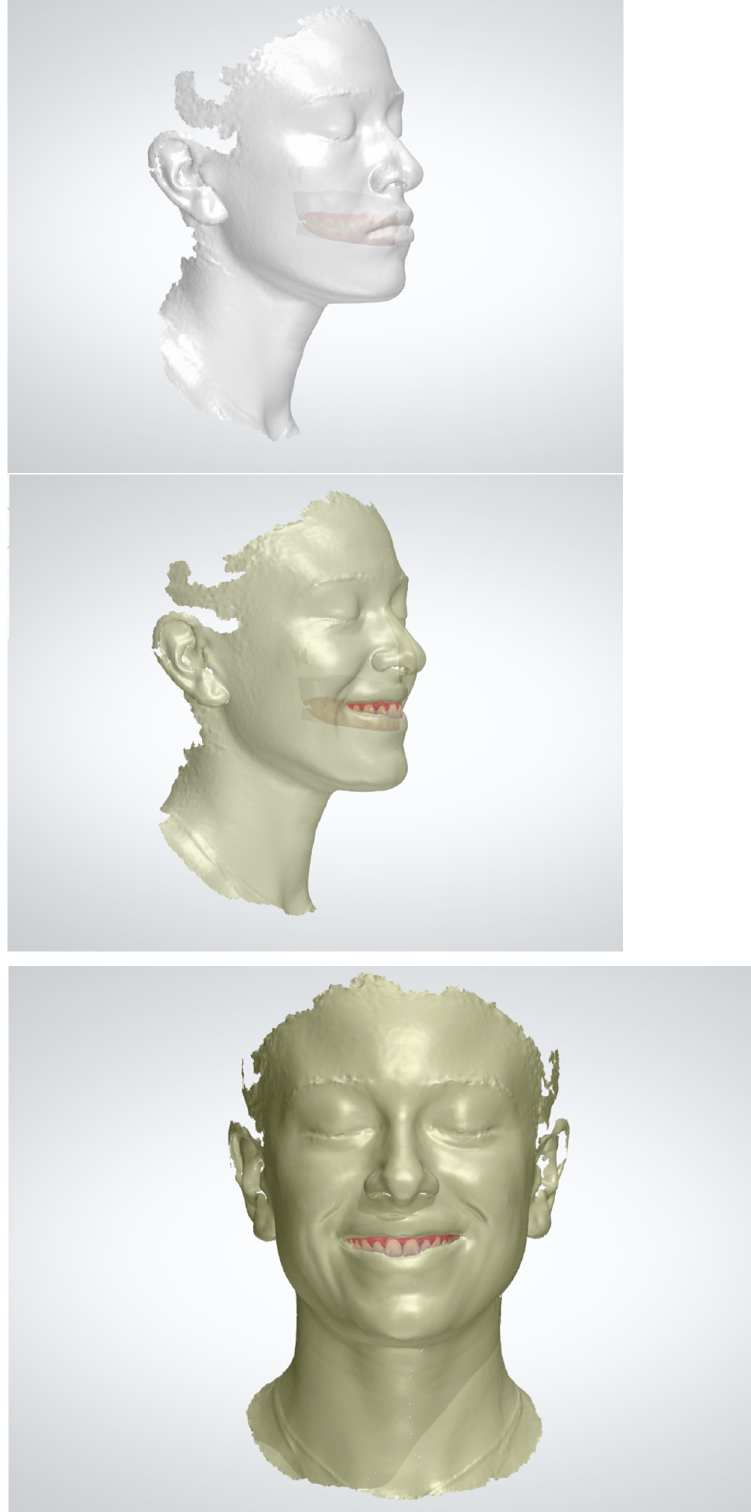
Figure 10. The virtual patient.